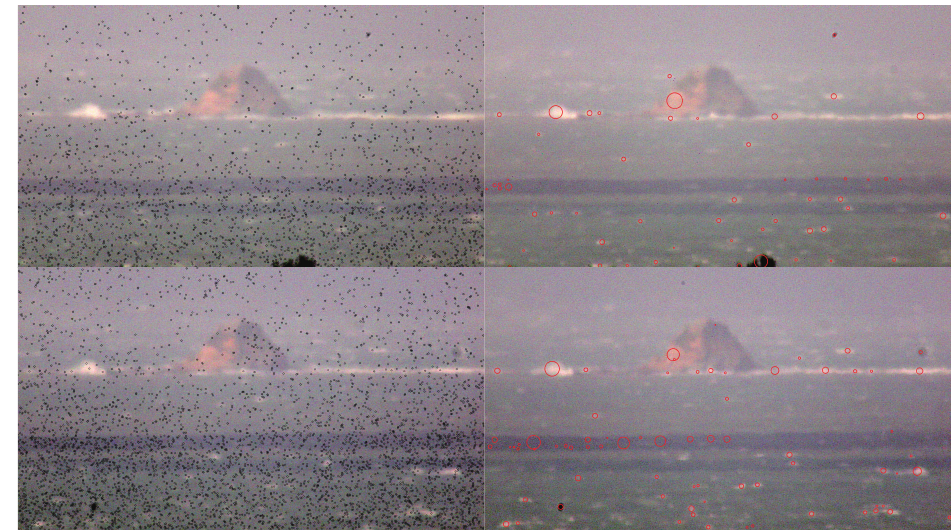
Figure 17. Feature points of the RANSAC+SURF method and our proposed method: 2018, distance: 0.8–1.4 × 10 4 m, from Fukuoka Institute of